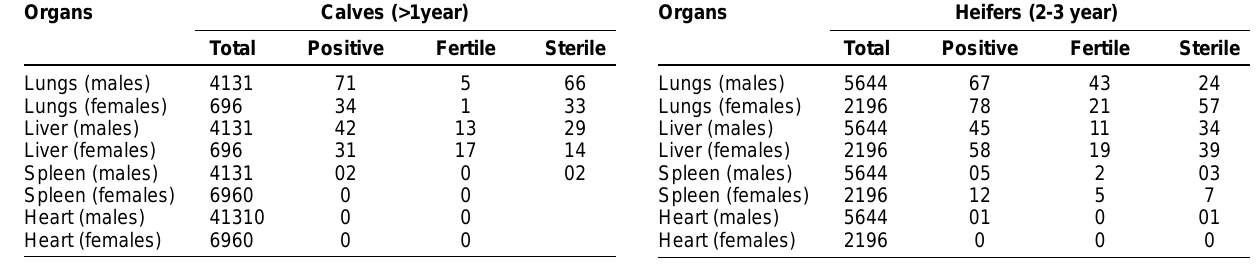
Table-4(a) In situ involvement of visceral organs and number of cysts recovered with their fertility rate in calves. Organs